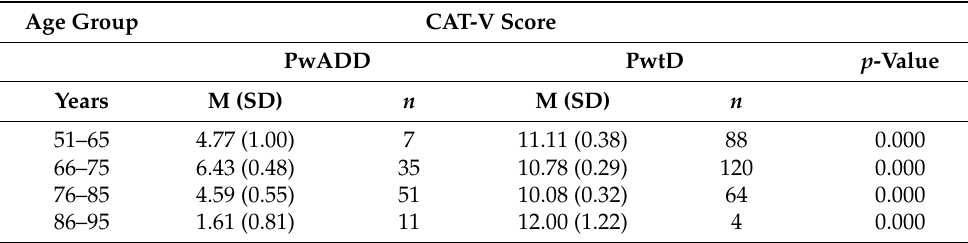
Table 3. Mean (M) and standard deviation (SD) of CAT-V performance in people with Alzheimer’s disease dementia (PwADD) and people without Alzheimer’s disease dementia (PwtD), depending on their age